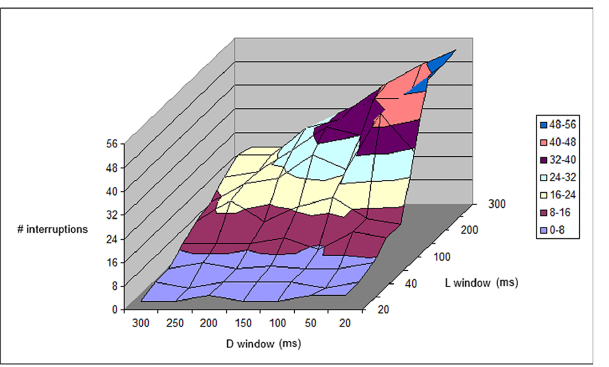
Fig 9. Plot of data given in Table 1. Number of interruptions with respect to L window and D window length, for a 5,000-ms period at 500 photons/s and a threshold of 6, as reported in Table